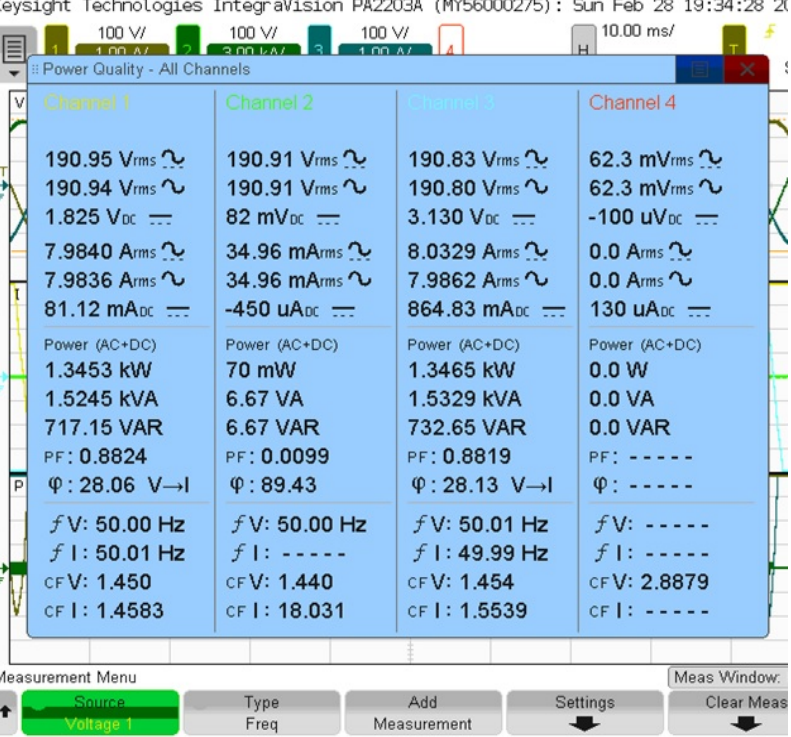
Figure 15. Voltage sag conditions in grid connected to induction motor under loaded conditions.